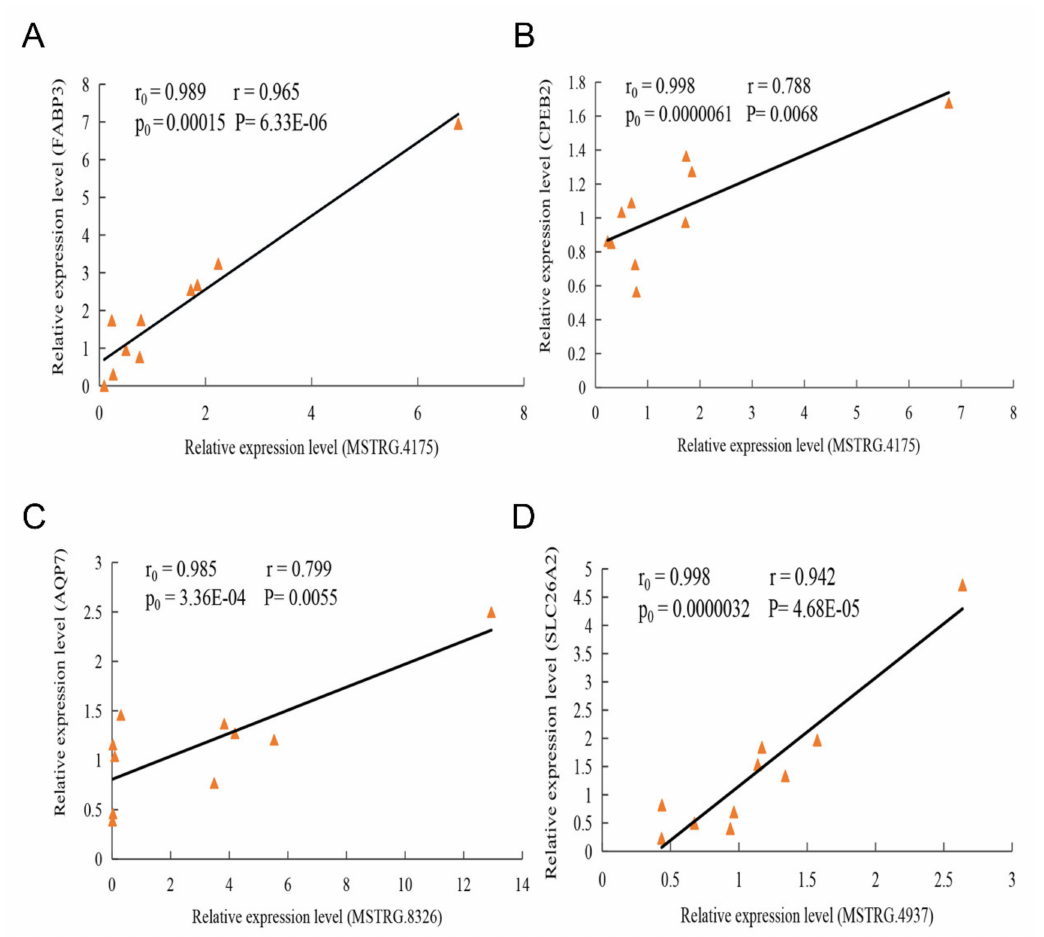
Figure 7. Linear regression of DEL and their DEPTG expression. The r0 and p0 represent the Pearson correlation coe ffi cient and p -value of each pair of DE LincRNA and its DEPTG in 6 samples (3 for Yorkshire group, and 3 for Wei group, respectively; while r and P represent verification in 10 samples. ( A ) MSTRG.4175 vs. FABP3 ; ( B ) MSTRG.4175 vs. CPEB2 ; ( C ) MSTRG.8326 vs. AQP7 ; ( D ) MSTRG.4937 vs. SLC26A2